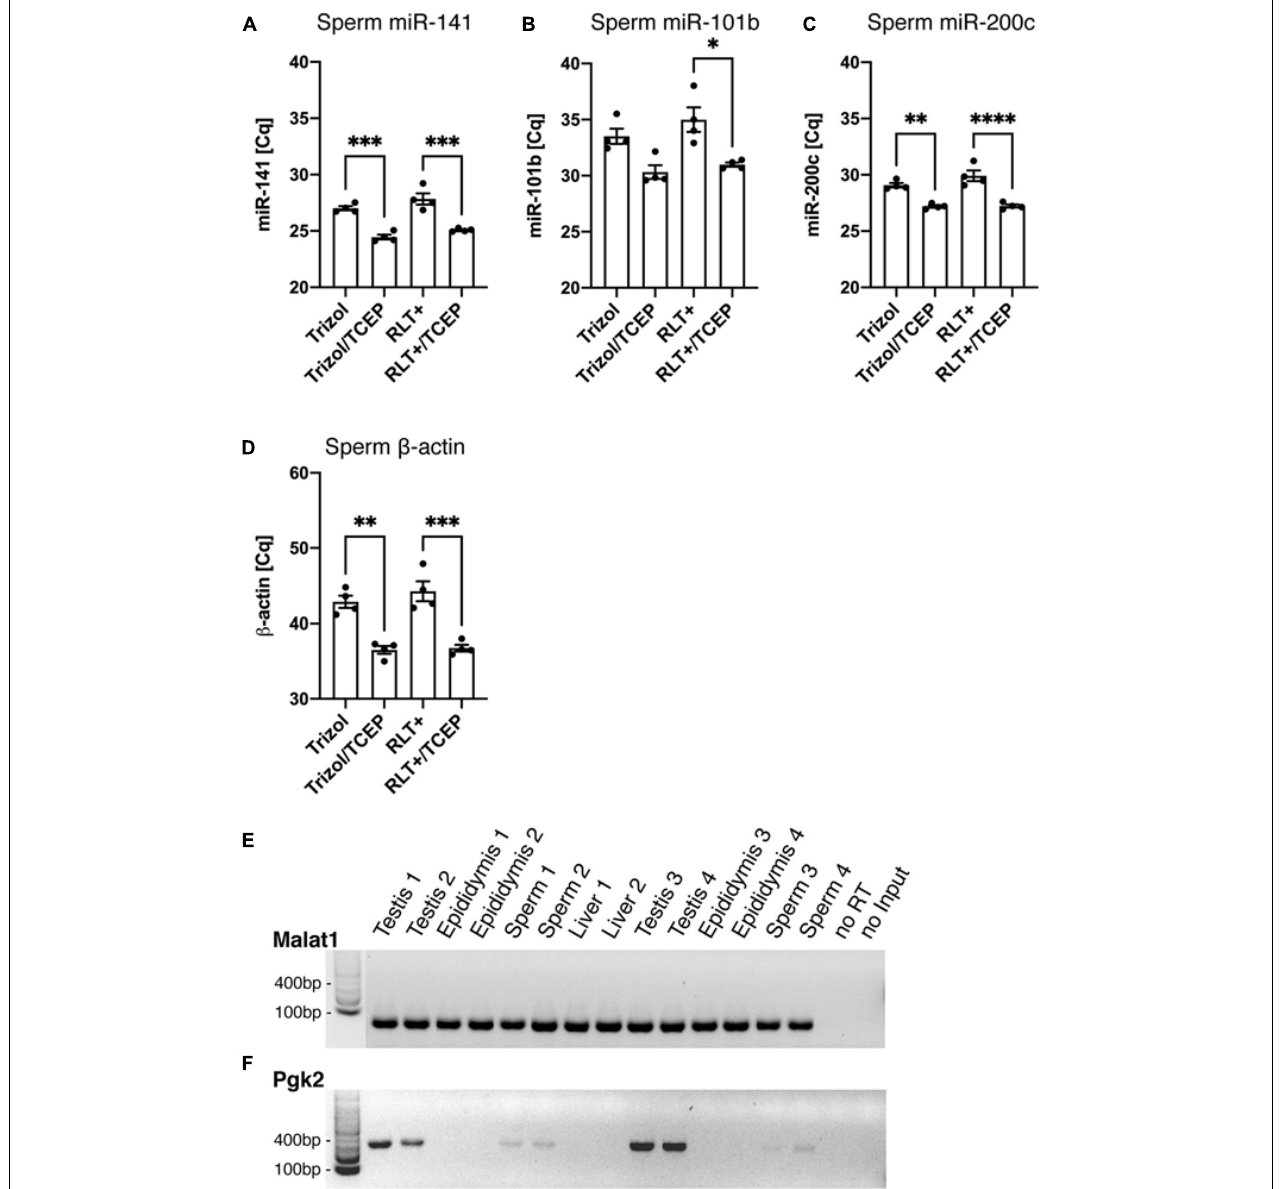
FIGURE 6 | Improved RNA yield quantified by qPCR of specific RNAs. (A–D) Quantification of RNA amount by qPCR. Detected cycle thresholds (Cq) are plotted on the y-axis and lower Cq values signify more starting material. (A–C) qPCR of miRNAs miR-141, -101b, and -220c. ( n = 4 per group). (D) qPCR of long RNA β -actin. ( n = 4 per group). (E,F) Gel images of end-point RT-PCR. (E) lncRNA Malat1 is detected by RT-PCR in Trizol/TCEP samples from sperm ( n = 4), testis ( n = 4), epididymis ( n = 4) and liver ( n = 2). (F) The germ-line specific transcript Pgk2 is only present in sperm and testis. noRT = RNA not reverse transcribed. NoInput = Sample without RNA. Significant ANOVAs were followed by Tukey’s post hoc test, * p < 0.05, ** p < 0.01, *** p < 0.001, **** p <